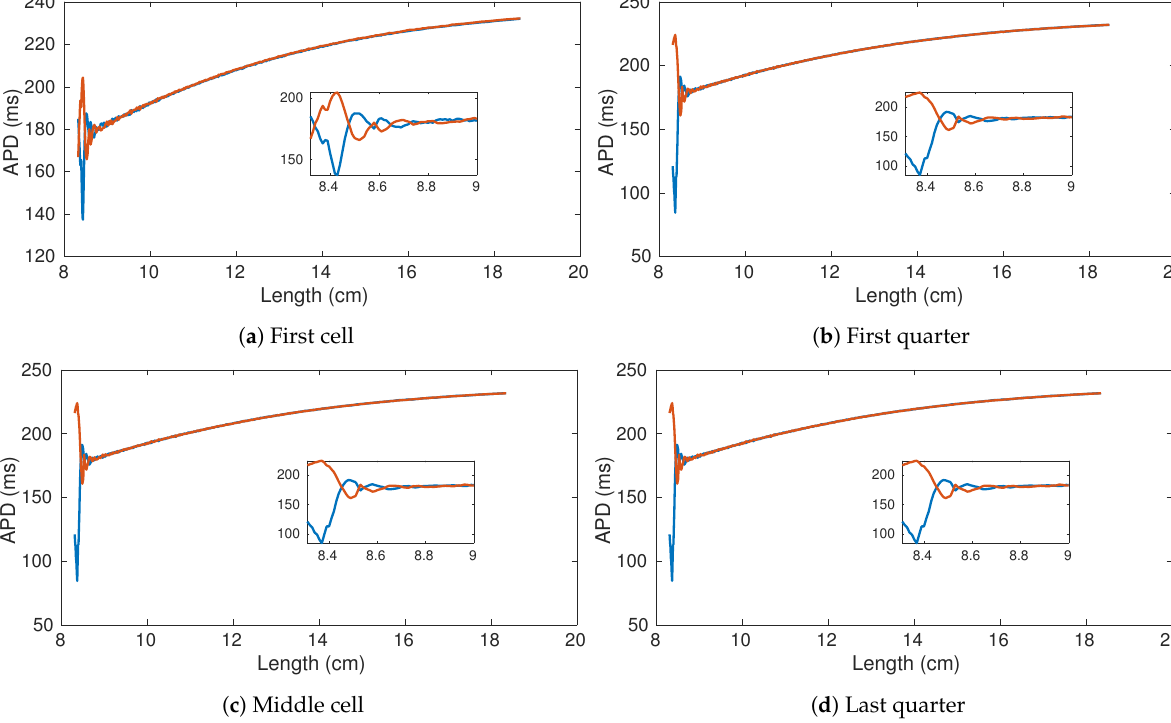
Figure 10. Bifurication diagrams of four sampled cells within the decreasing ring experiment. The original number of cells is 2500 (25 cm). von Mises Distribution parameters µ = 1.98, κ =